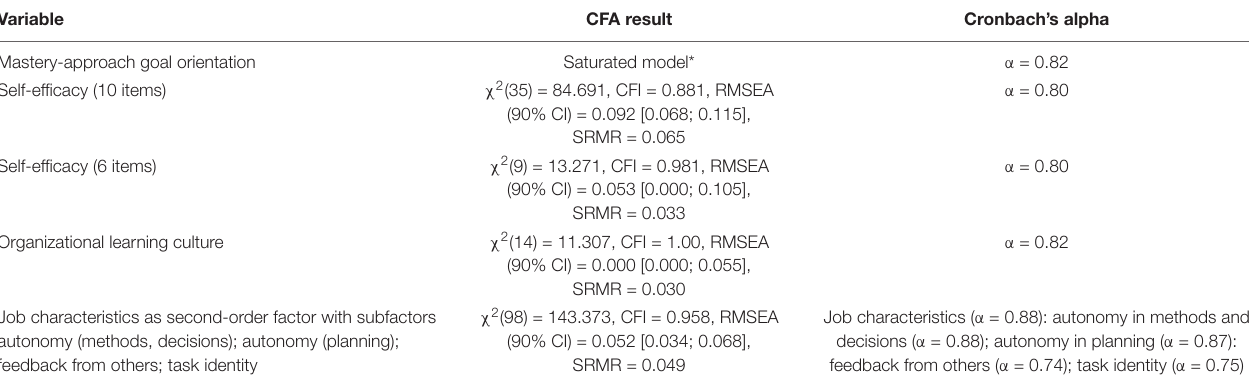
TABLE 1 | Result of confirmatory factor analysis and Cronbach’s alpha of the study variables without SRL